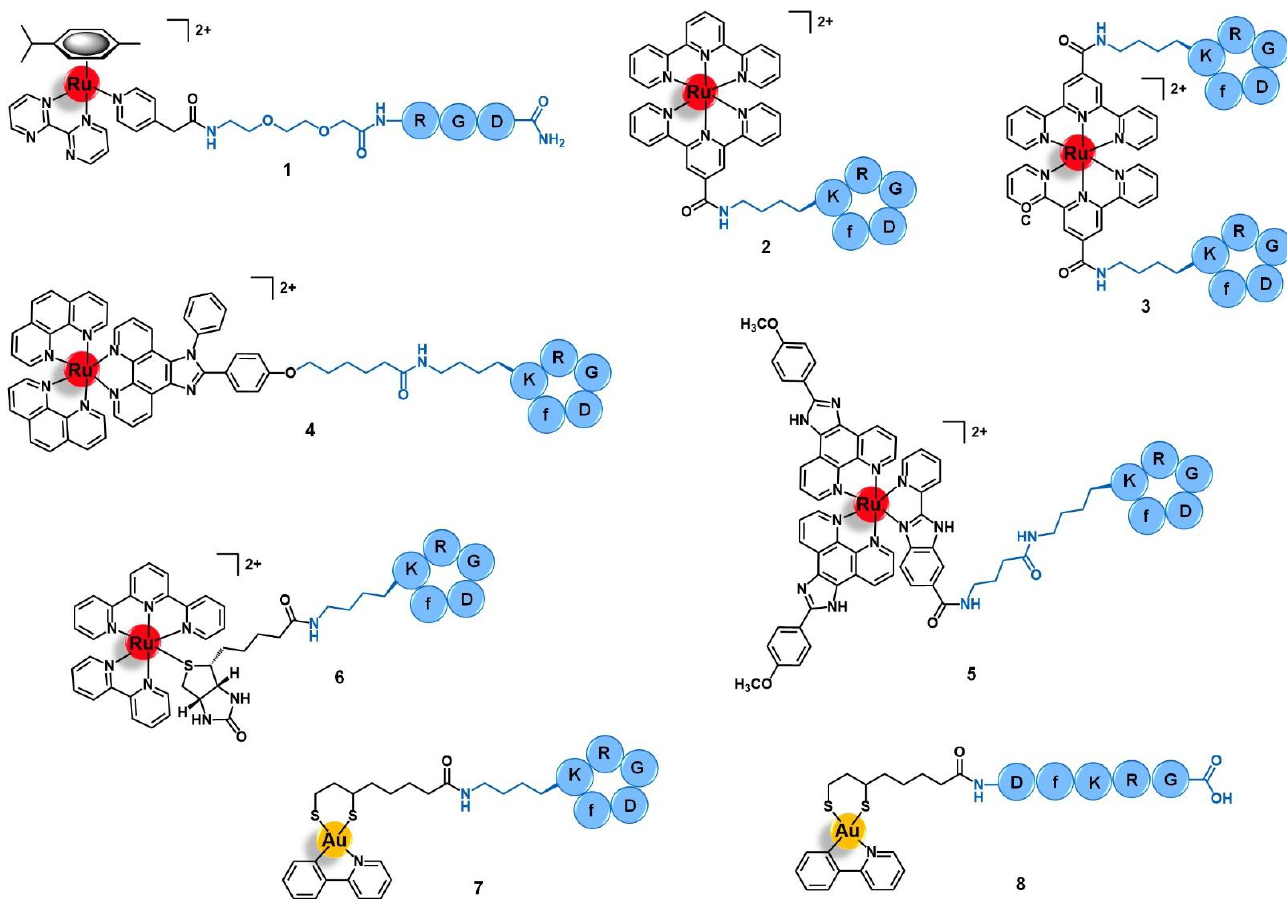
Figure 3. Ru(II)- and Au(III)-conjugates containing an integrin-targeting peptide as the delivering agent of the active metal complex into cancer cells: conjugates with the peptides RGD ( 1 ), cyclo- RGDfK ( 2 to 7 ), and DfKRG ( 8 ). Note: f = D -phenyl- alanine.